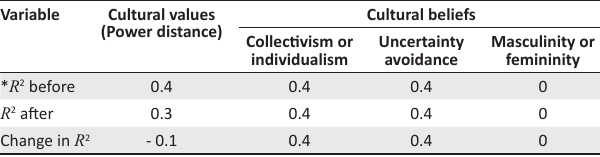
TABLE 5: Regression results for the factors influencing the relationship between SHRM practices and motivation at work. Variable Cultural values (Power distance)